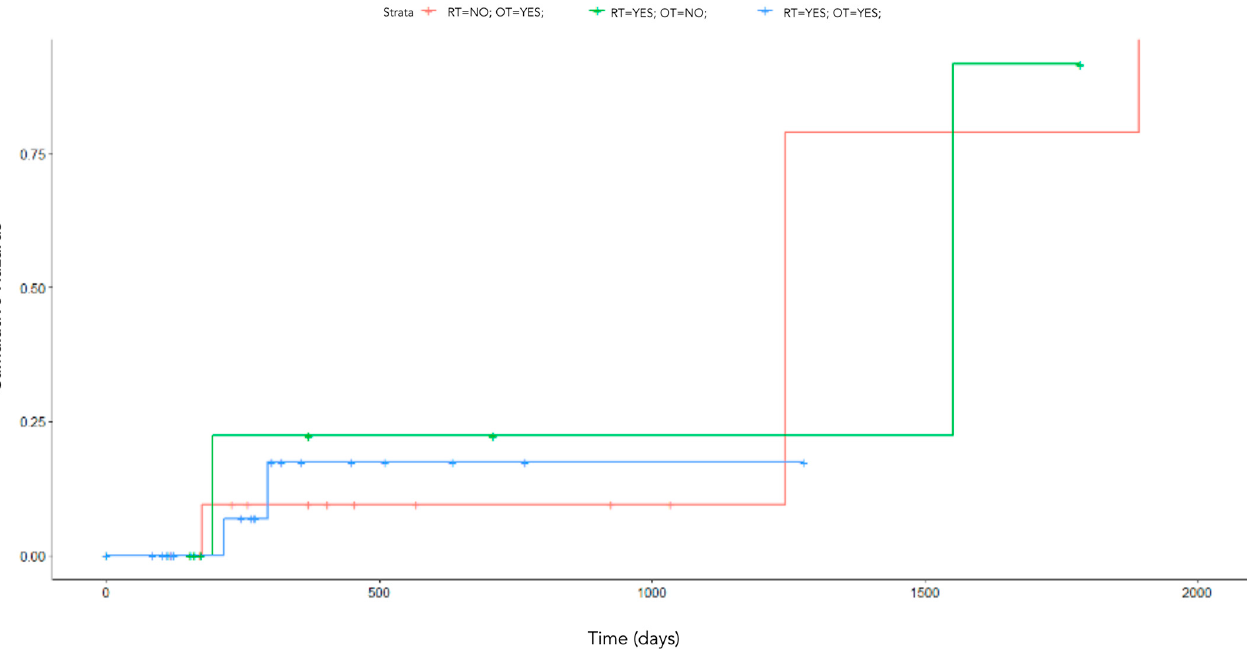
Figure 9. Kaplan–Meier cumulative hazards of patients stratified according to type of treatment, i.e., patients who underwent hormonotherapy (red curve), radiotherapy (green curve), or both (blue curve).